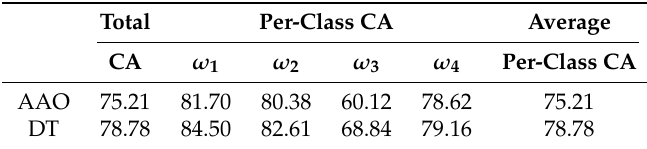
Table 2. Classification accuracy (%) for simulated test dataset C4-F25 for all-at-once (AAO) and decision-tree (DT) classifier.